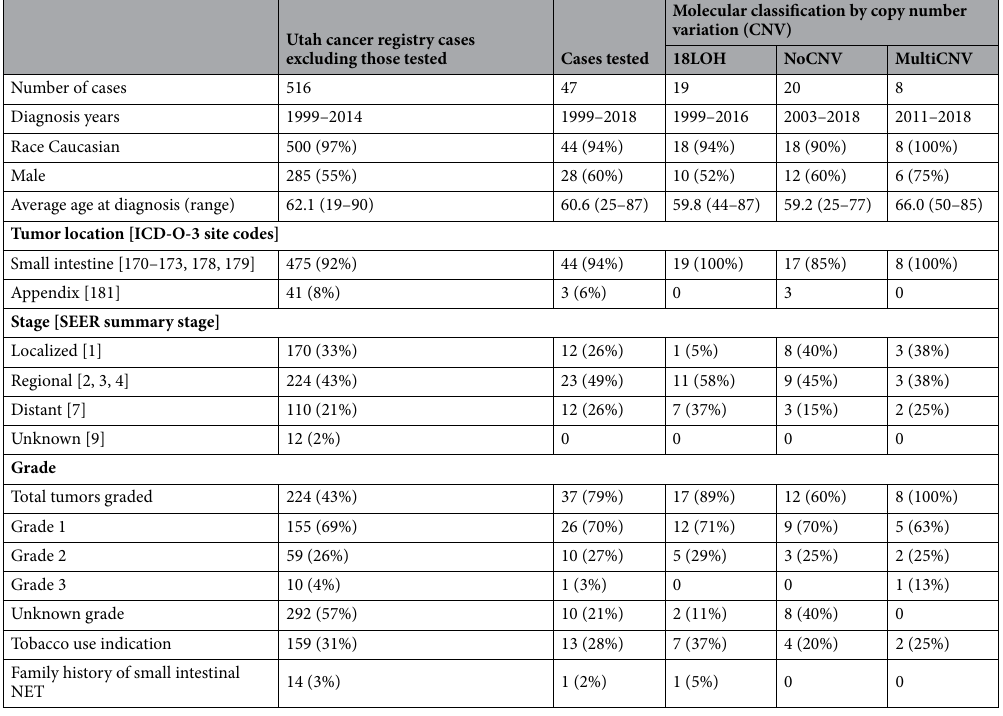
Table 1. Characteristics of NET cases